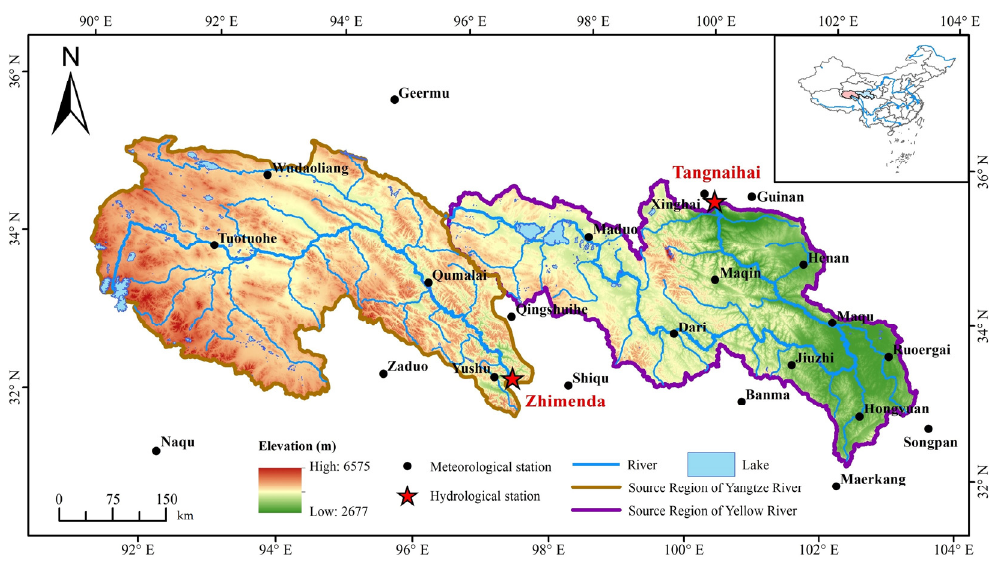
Figure 2. Geographical location of study area and hydrometeorological stations.